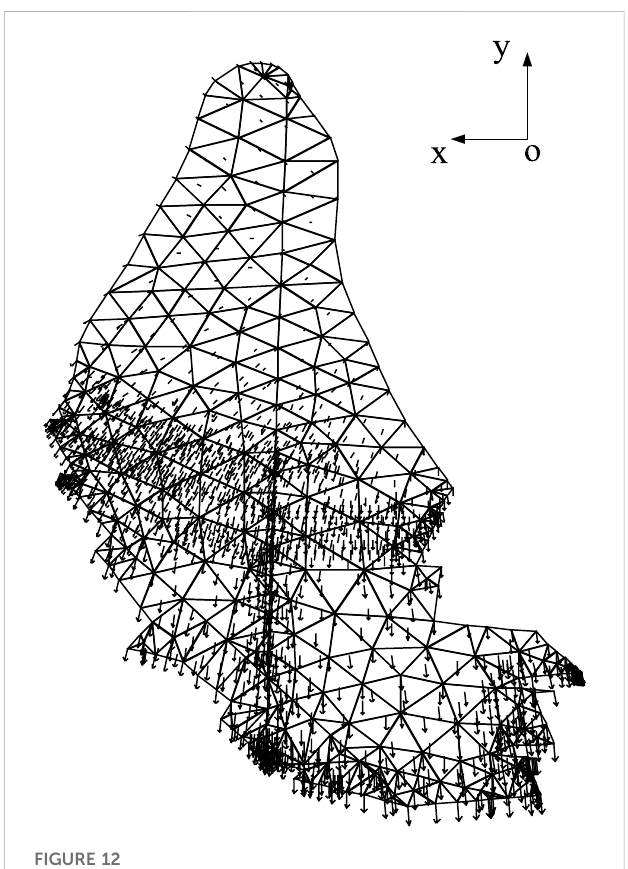
FIGURE 12 States of interface nodes for the rock block of the right dam slope.